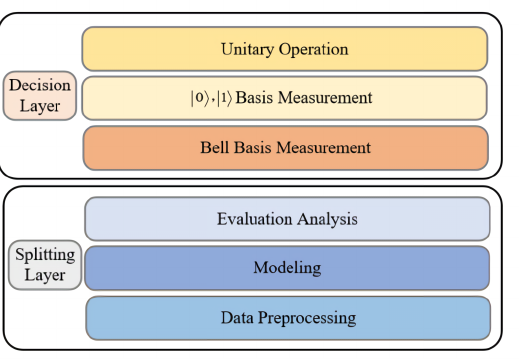
Figure 1. Overall